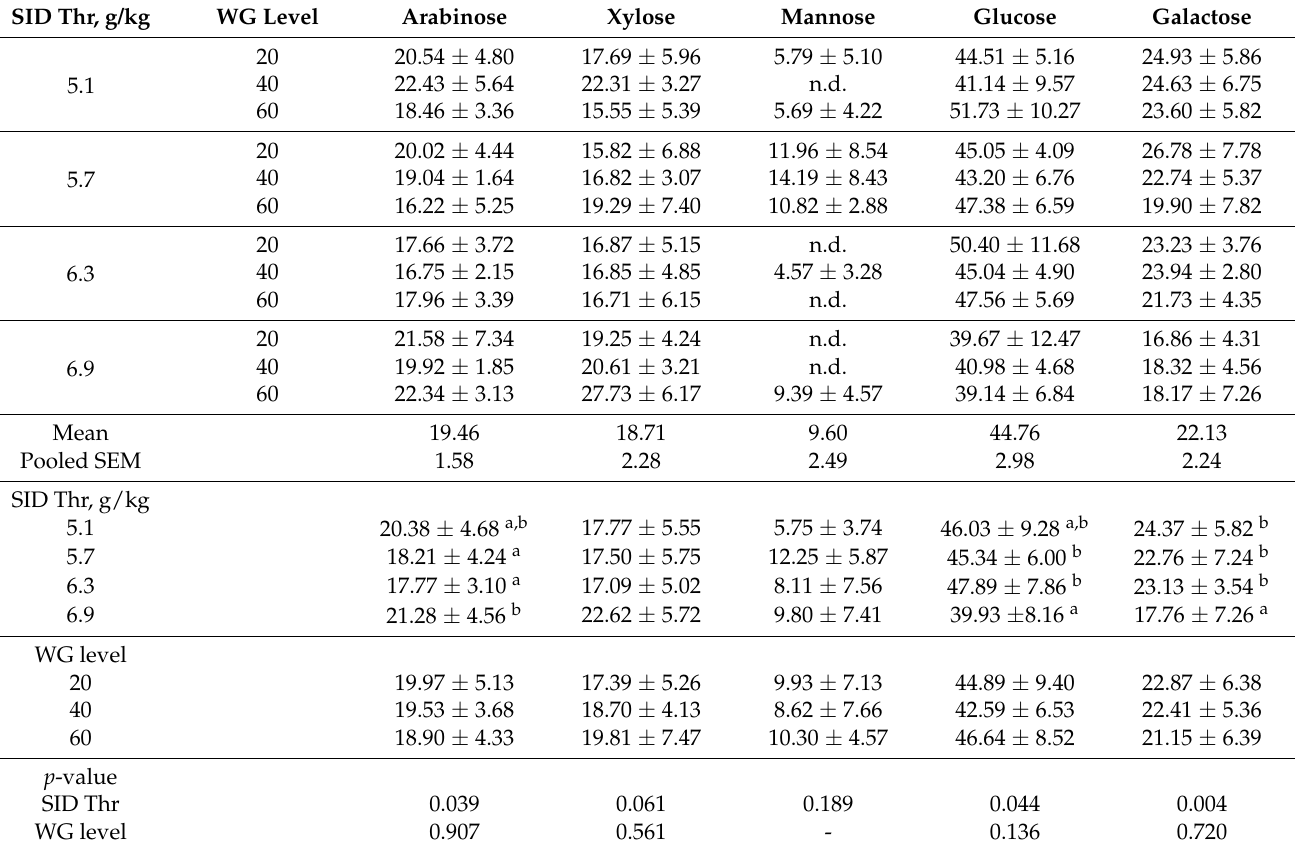
Table 5. Sugar composition (mol/100 mol) of crude mucins preparations isolated from colonic digesta of pigs fed diets differing in standardized ileal digestible threonine (SID Thr) content and wheat gluten (WG)